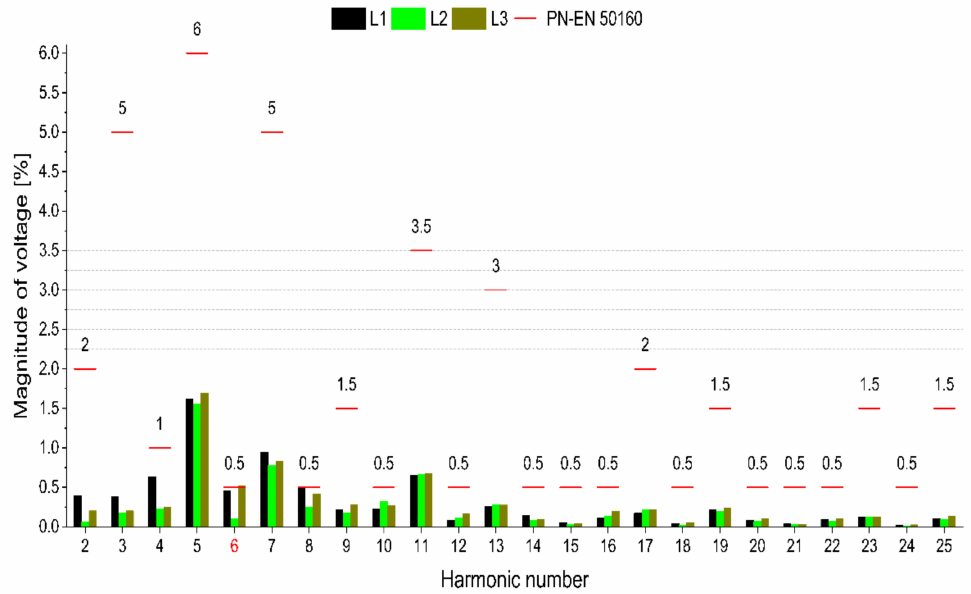
Figure 10. Voltage harmonic spectrum (95th percentile) for the entire week. Table 2. Numeric values of each individual voltage